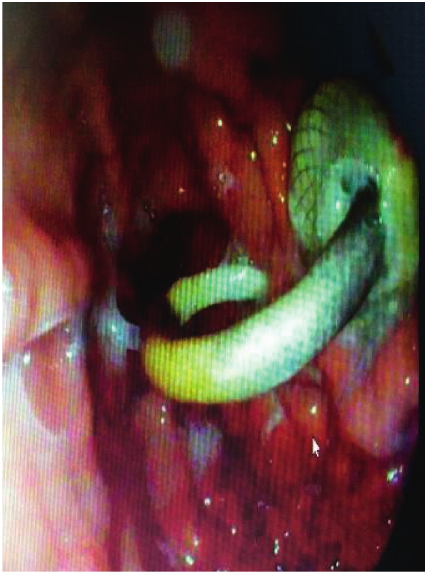
Figure 4: Hot AXIOS and double-pigtail stents at the time of